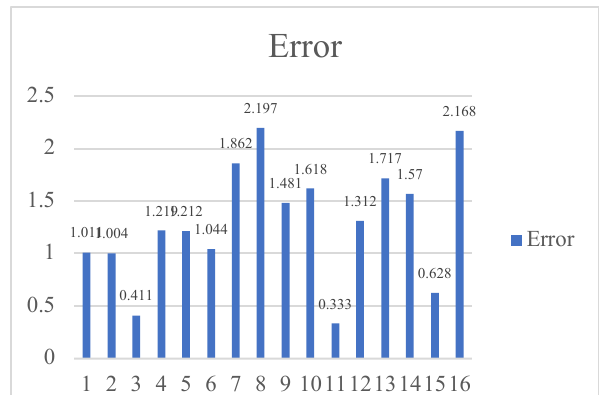
Figure 4. Value of the differences height between Conventional and UAV method.